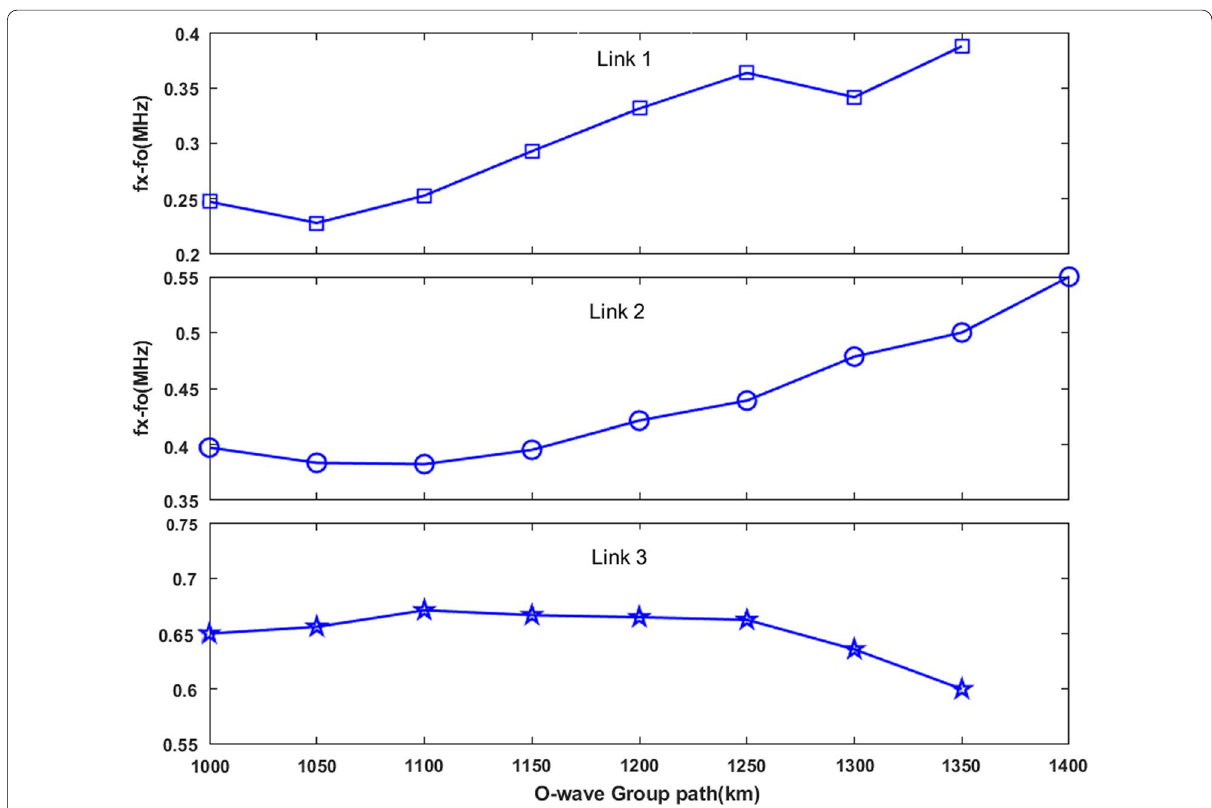
Fig. 9 Correlation between the separation and O-wave group path